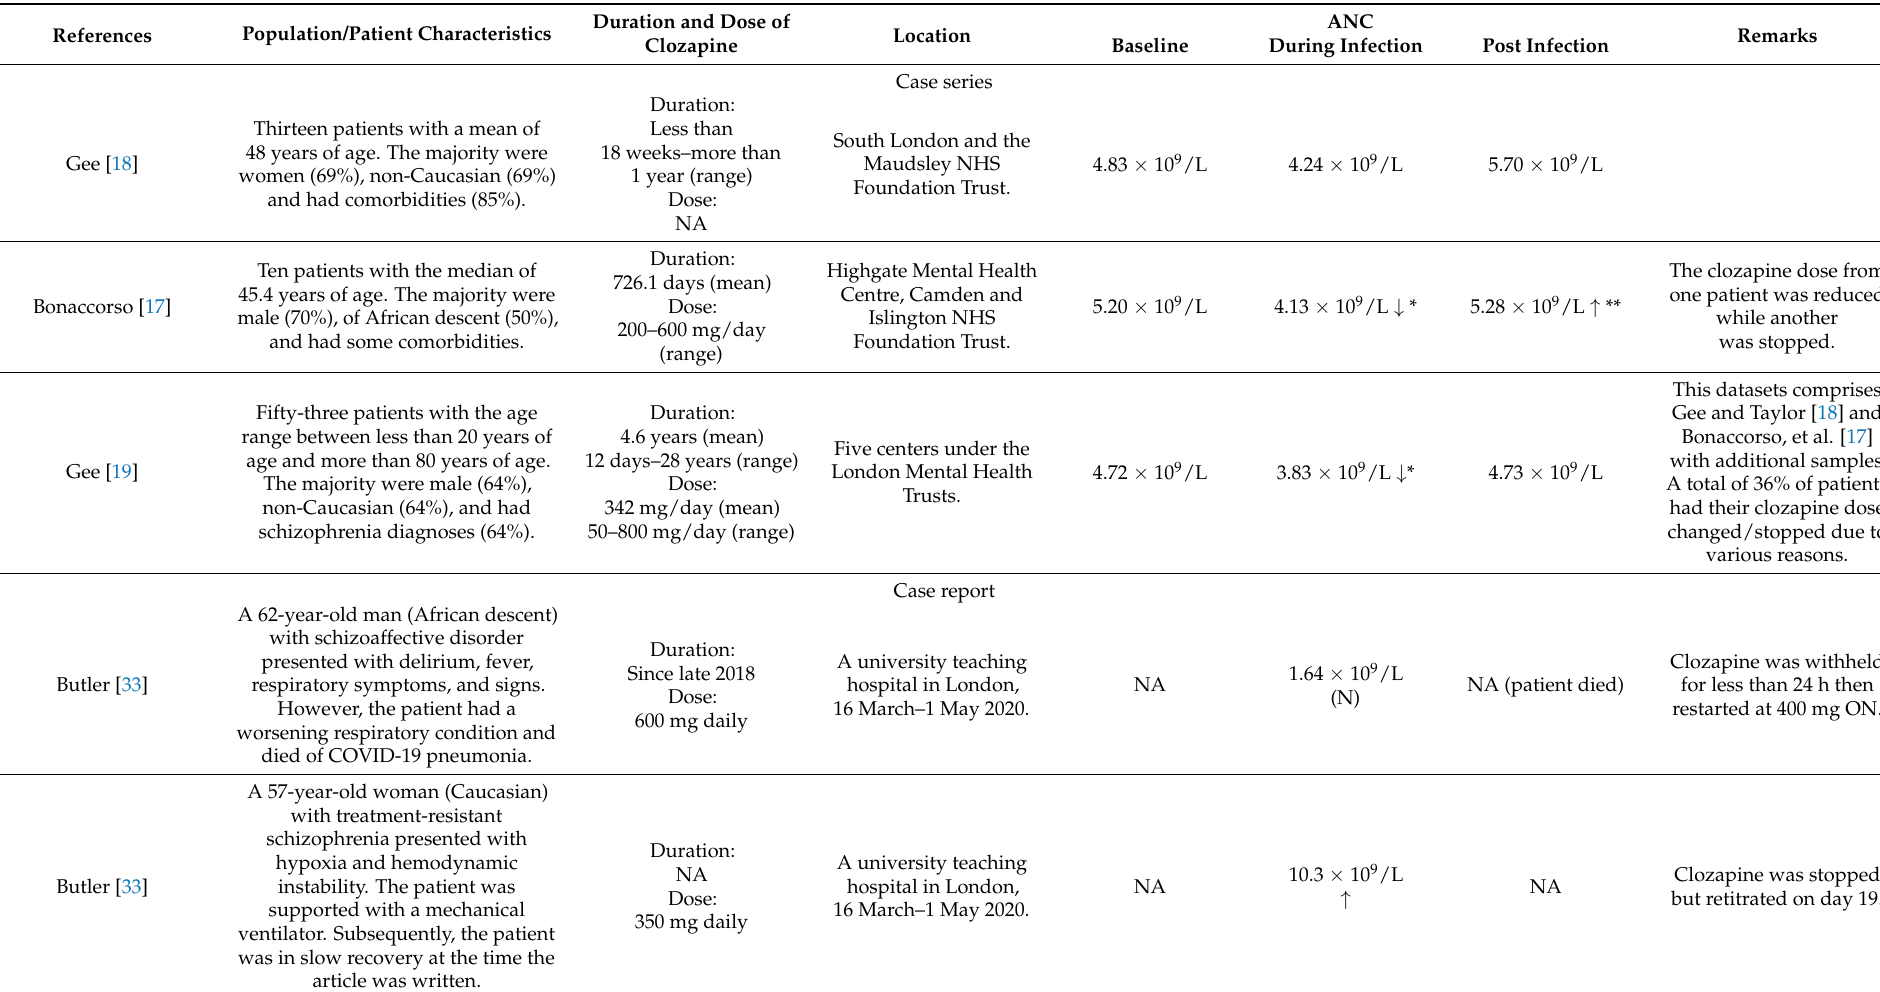
Table 1. Characteristics of case series and case reports included in the